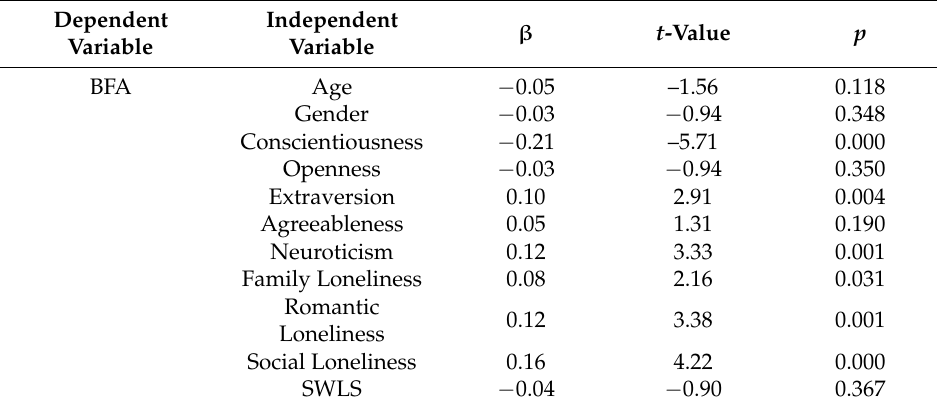
Table 4. Results of linear regression analysis of Bergen Facebook Addiction ( n =